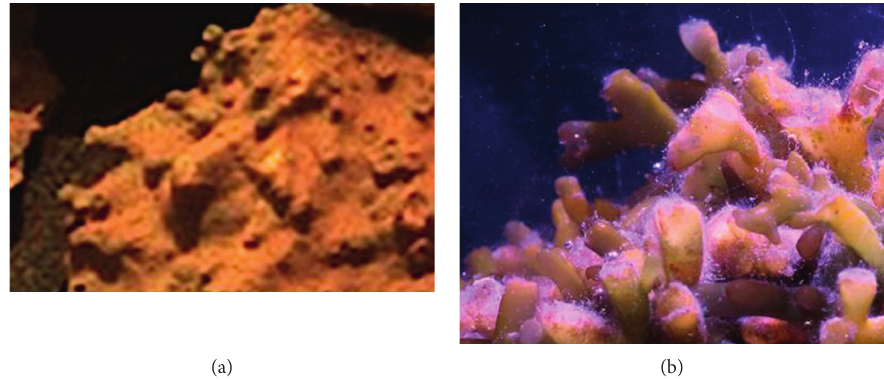
Figure 6: Sol 232 (a): cone-like formations that resemble gas-vent apertures for the release of oxygen secondary to photosynthesis by algae/ cyanobacteria and which appear to be moist. If they are alive, fossilized, or abiotic is unknown. (b) Cone-like tubes for the venting of oxygen produced by photosynthesizing water-dwelling algae (reproduced with permission from [31]).